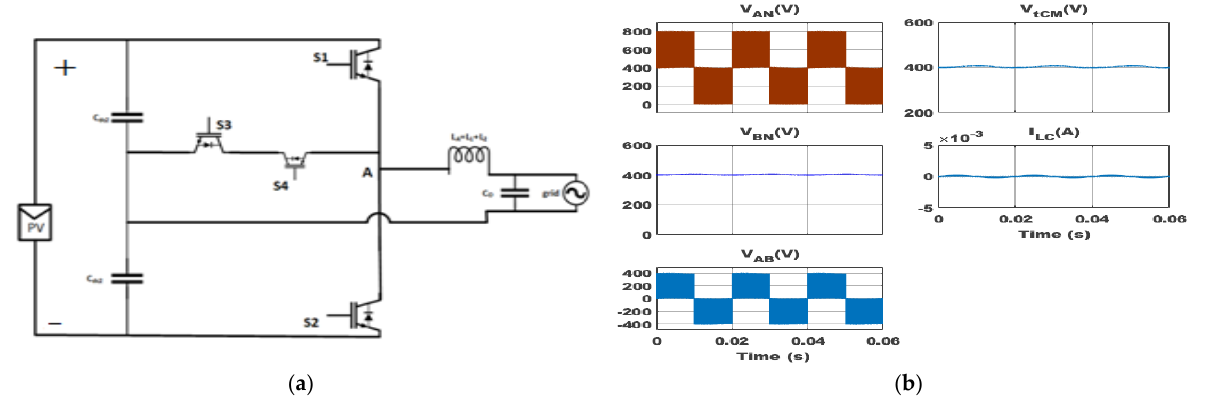
Figure 23. Conergy NPC topology: ( a ) circuit structure; ( b ) simulation results.